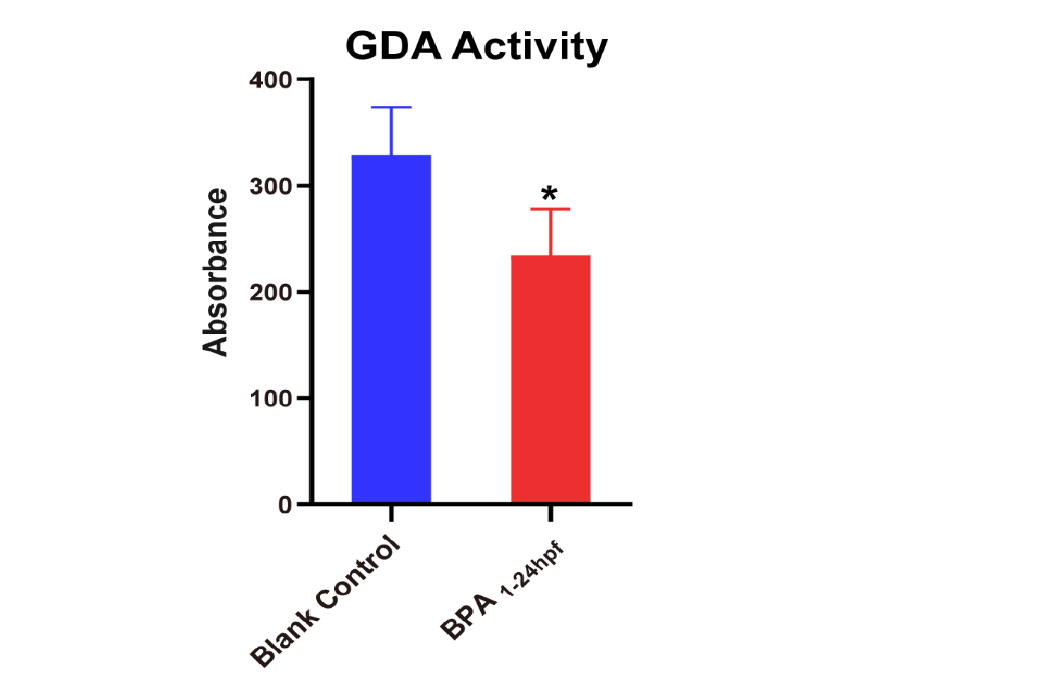
Figure 7. Effects of exposure to BPA on GDA enzyme activity in zebrafish embryos from the cleavage period to the segmentation period (1–24 hpf). Data are the mean ± SD, *, significant from blank control, p < 0.05.